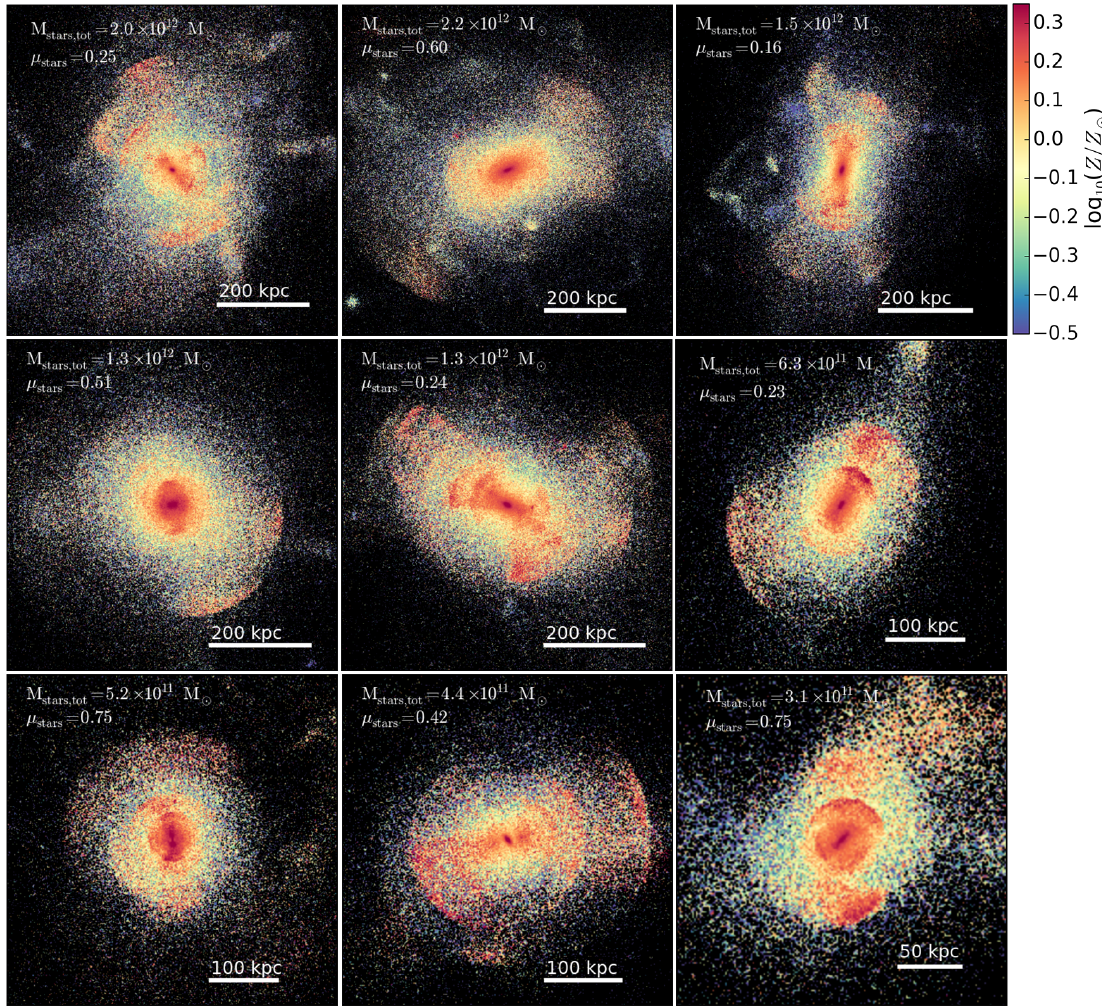
Figure 3. Examples of nine different massive elliptical galaxies with shells from the Illustris simulation. The color of each bin of area A bin = ( 1.5kpc ) 2 in the 2D histograms above corresponds to the median total metallicity (Z) of all star particles therein. The total stellar masses of these galaxies range from M stars = 3.1 × 10 11 M (cid:12) to M stars = 2.2 × 10 12 M (cid:12) , while the virial masses are in the range (cid:0) (cid:1) M 200crit ∈ . For several of the shell galaxies in our sample, stellar shells 6.5 × 10 12 M (cid:12) , 6.3 × 10 13 M (cid:12) are metal-rich compared to the total metallicity (Z) of stars in the outer stellar